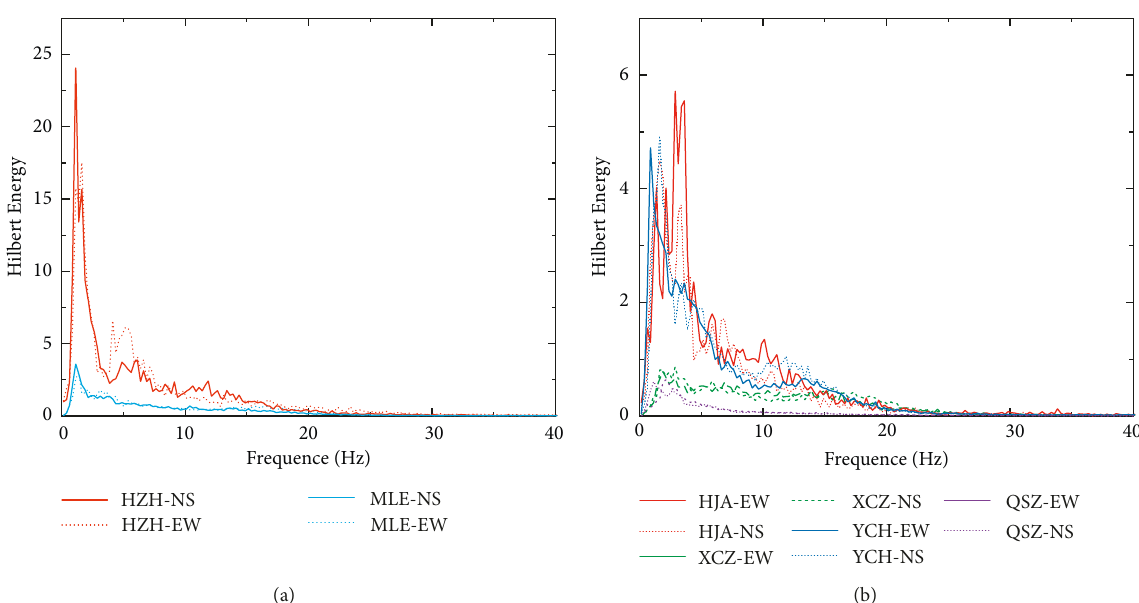
Figure 6: Marginal spectrum of each strong motion station. (a) Ms 5.0 (b) Ms